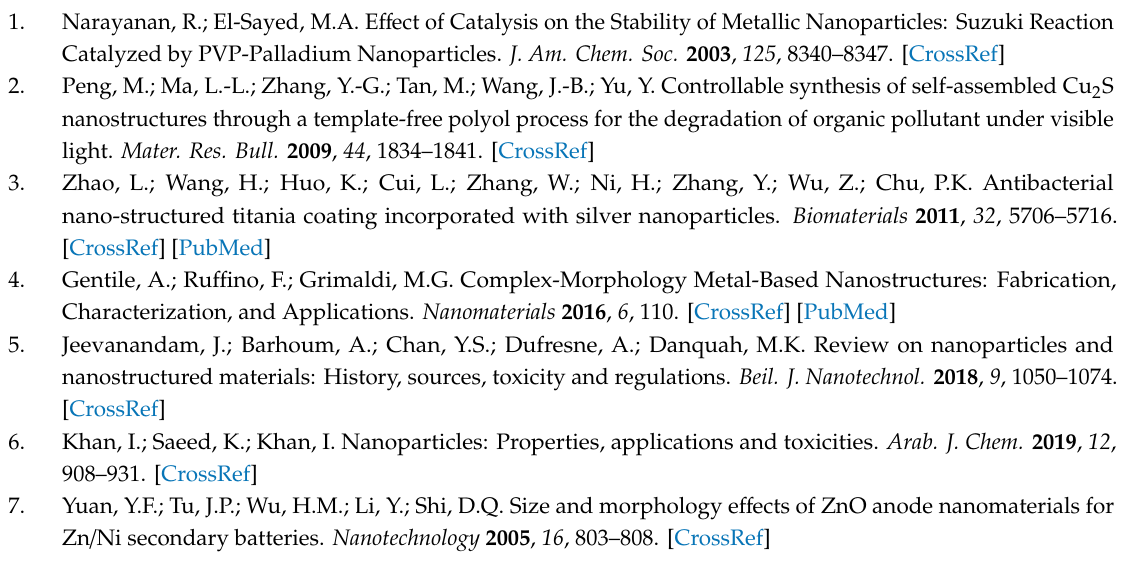
Figure S1: SEM images of as-prepared free standing Cu 2 S nanowire grown under di ff erent reaction conditions. The three conditions are added (a) 4 mL, (b) 7 mL, (c) 10 mL ethylenediamine with 10 g sodium hydroxide at 70 ◦ C for 10